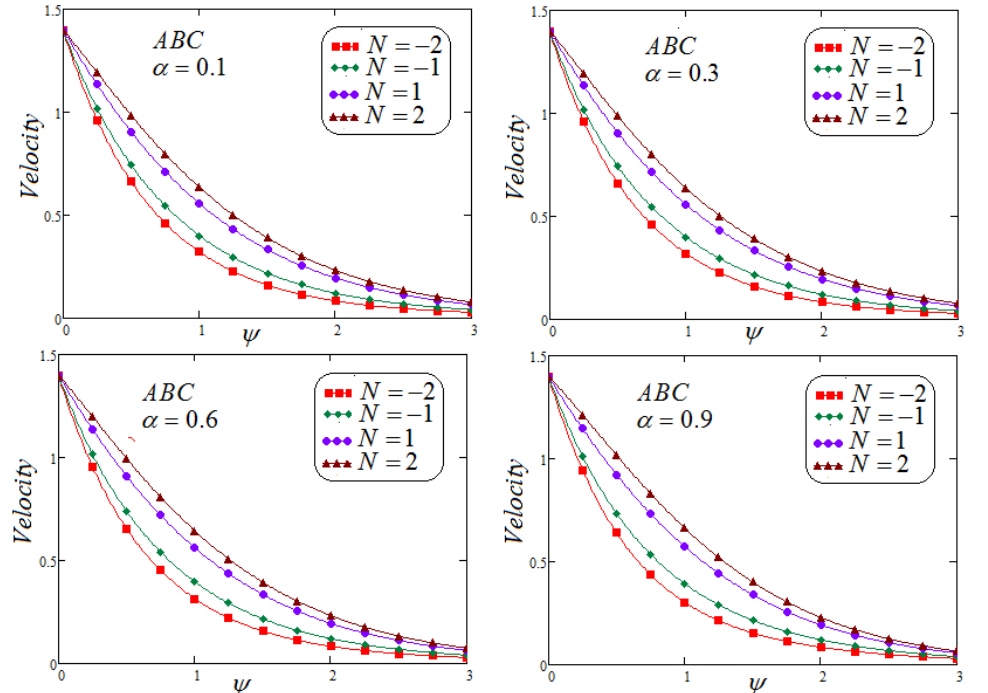
Figure 8. Trace of dimensionless velocity for dissimilar values of N via